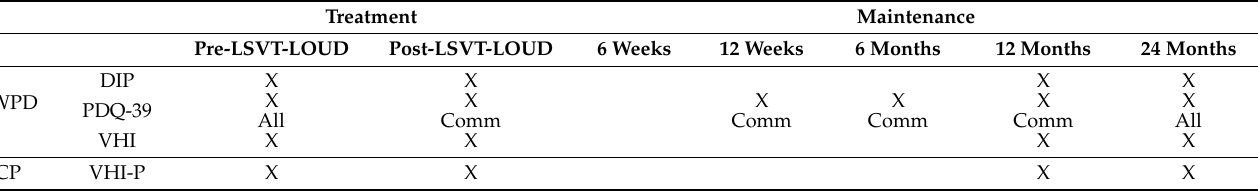
Table 2. Quality of life rating scale